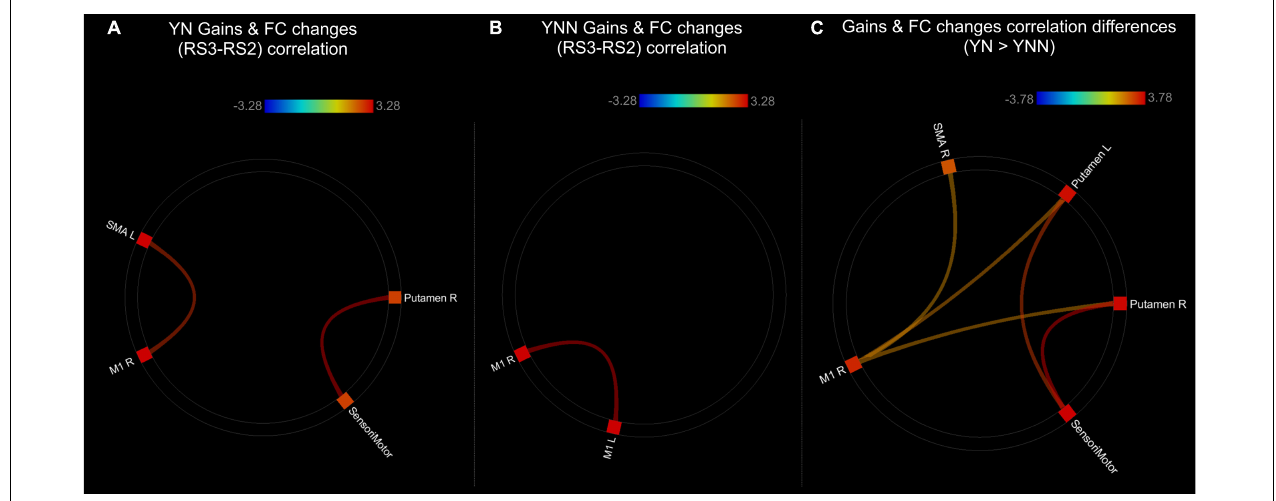
FIGURE 8 | Associations between post-MSL FC changes and performance gains in (A) YN group; (B) YNN group; (C) YN showed stronger brain-behavioral associations than YNN group. Thresholded at p FDR < 0.05. YN, Young Nap; YNN, Young No